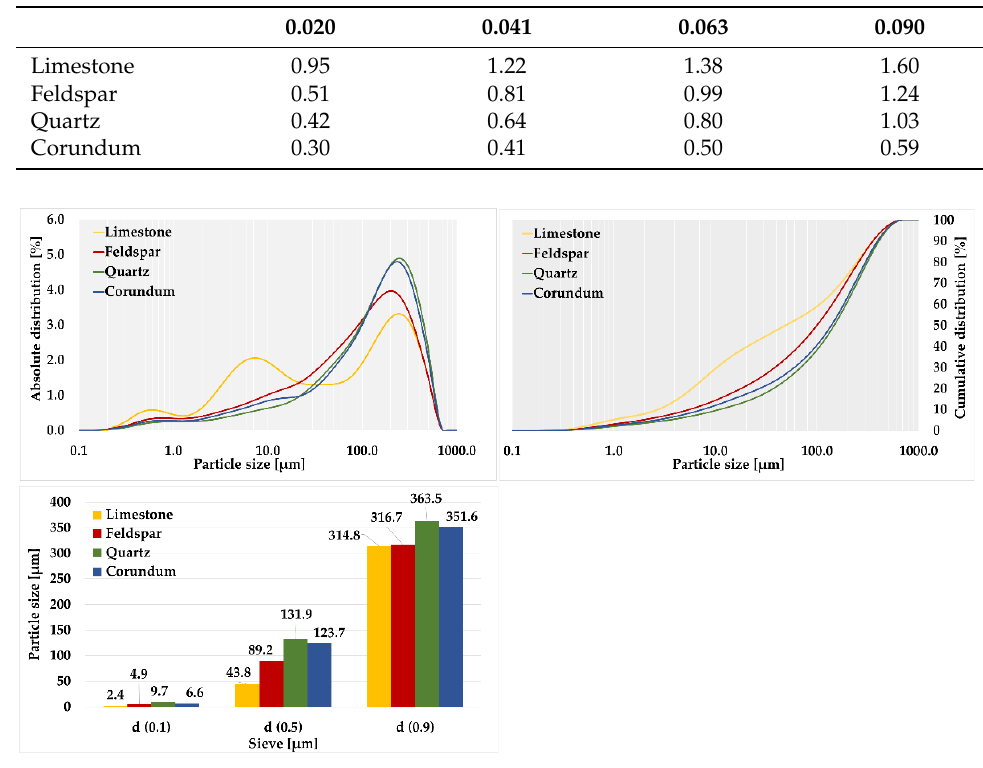
Figure 3. Laser granulometry of quartz, limestone, feldspar, and corundum. For corundum, the highest average value of over-sieve share per 0.090 mm mesh was Table 8. Sieve analysis of materials after grinding, over sieve (%). observed, 85.14%. The lowest average value of over-sieve share fraction was observed for limestone, at only 48.80%. The average value of over-sieve share was 61.38% for feldspar and 69.08% for silica.